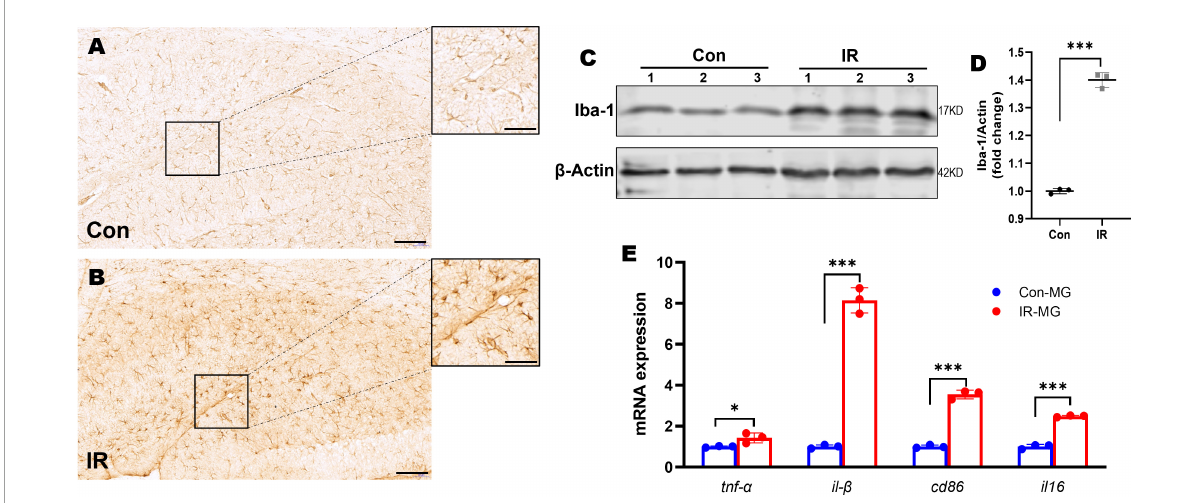
FIGURE3 Microglia activation and M1 polarization in HFD-induced IR mice. (A,B) Iba-1 IHC staining in hippocampus, panel (A) showed control mice, panel (B) showed IR mice. n = 3 per group. (C) Representative blot images of Western blot for Iba-1 protein expression in the whole hippocampus. β -Actin served as an equal loading control. (D) The corresponding densitometry of Iba-1 (fold change of control group). n = 3 per group. (E) The expression of CD86, CD16, TNF α , and IL-1 β mRNA in purified microglia from mice brains by qPT-PCR. n = 3 per group. Scale bar: 100 µ m in panels (A,B) , 20 µ m in the enlarged box in panels (A,B) . Data are expressed as mean ± SD. ∗ p < 0.05, ∗∗∗ p <